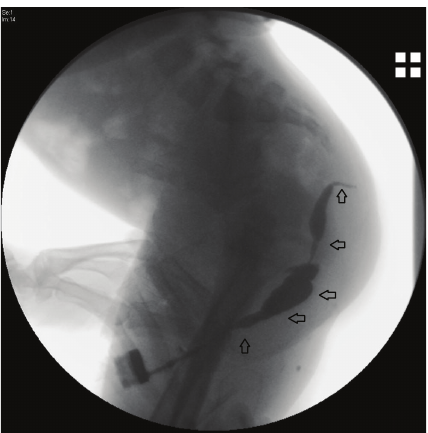
Figure 1: Fistulography of the patient. The opaque material was given from the mouth of the fistula at the level of the penoscrotal region. The opaque material extended superiorly to the inferior level of the coccyx and terminated under the